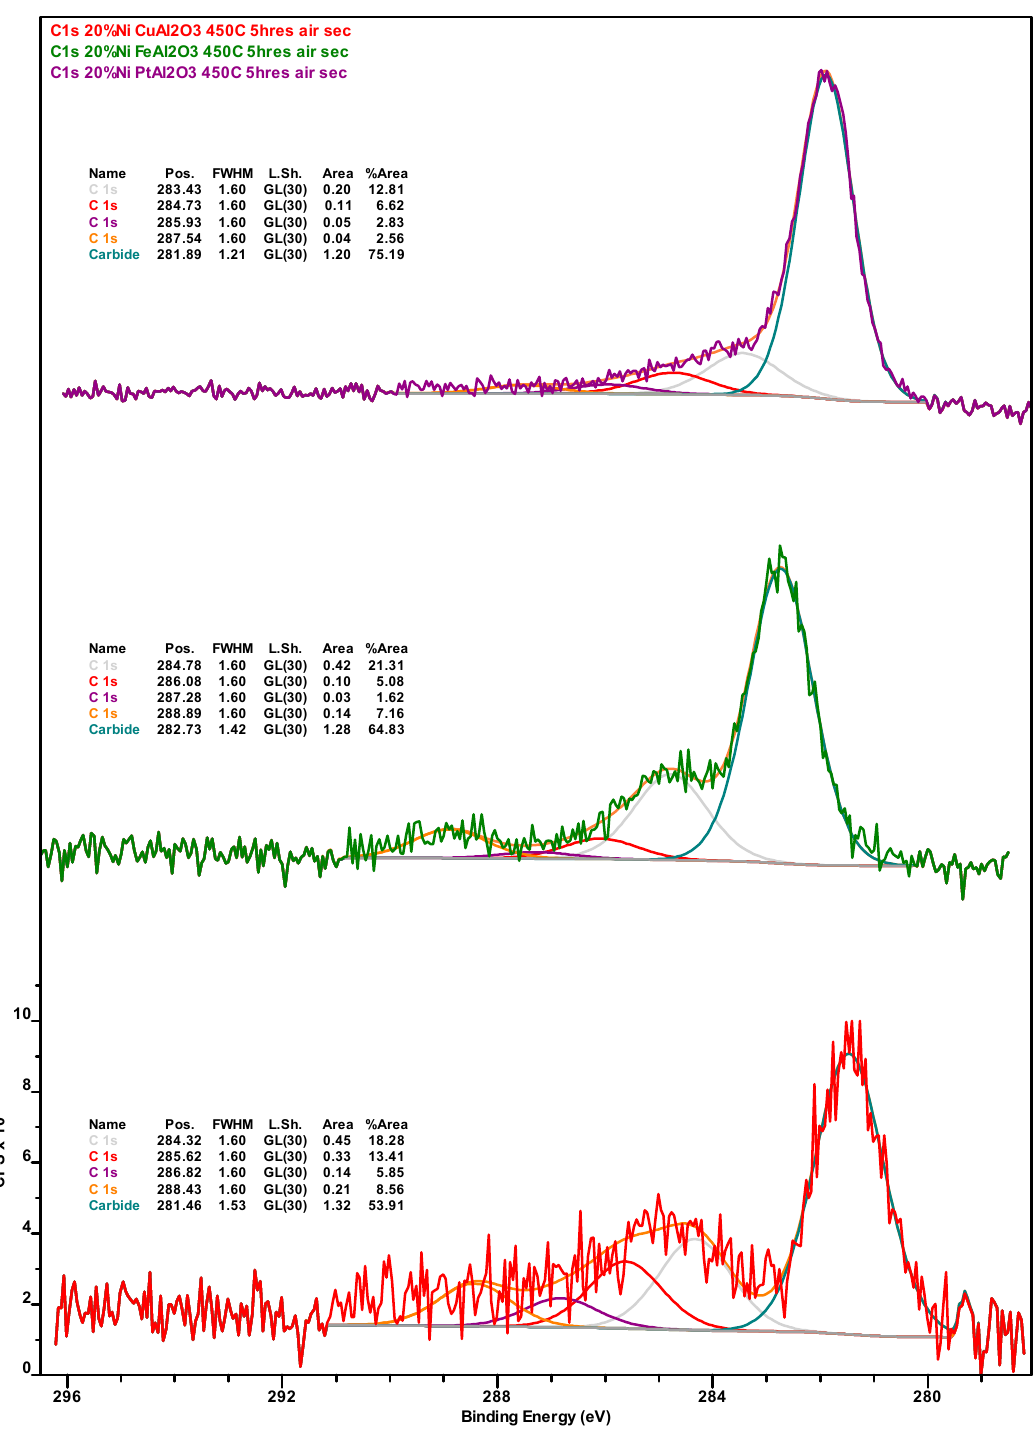
Figure A5. Carbon 1s X-ray photoelectron spectra of the spent Ni-Cu (red spectrum), Ni-Fe (green spectrum), and Ni-Pt (purple spectrum) catalysts recovered from the deoxygenation experiments after calcination in air at 450 °C for 5 h.